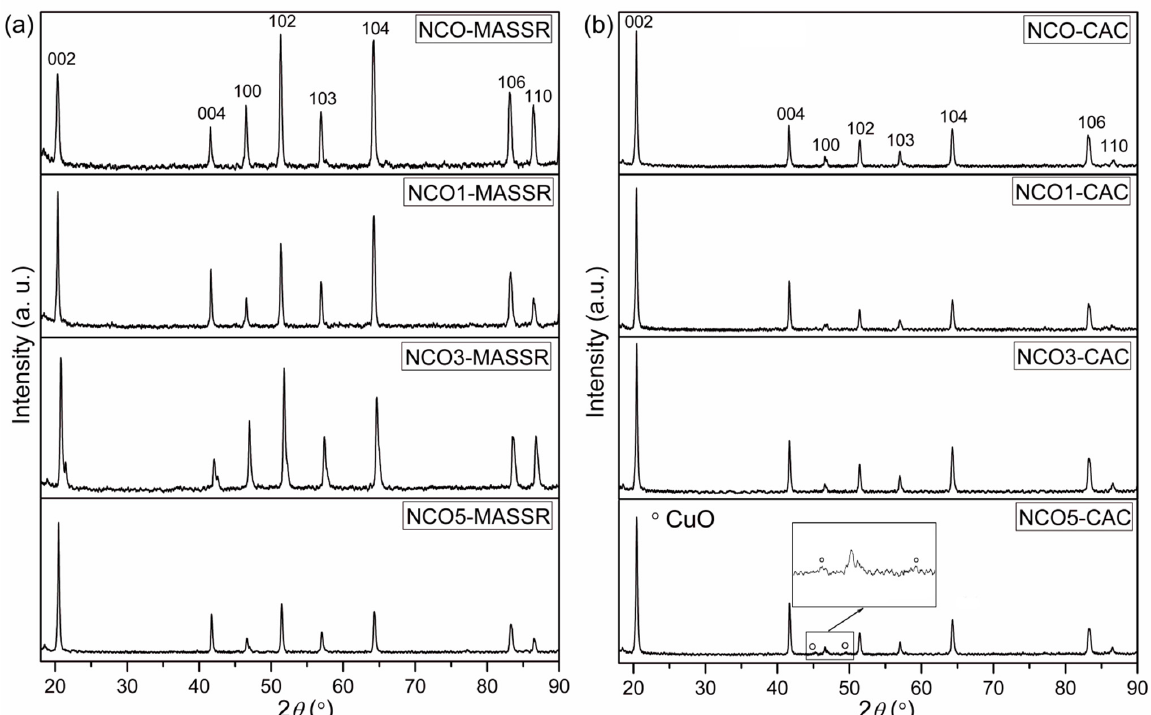
Figure 1. XRD patterns of the ( a ) MASSR and ( b ) CAC samples.